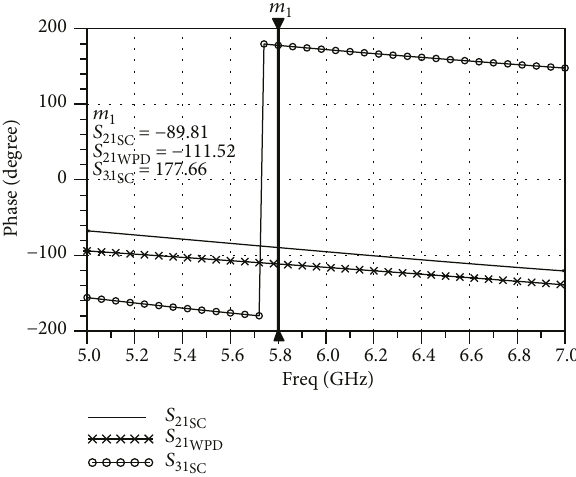
Figure 8: Phases of the scattering parameters of the symmetric coupler (SC) and Wilkinson power divider (WPD) simulated in ADS schematic with C = 7 dB, K = 1 , and R = 100 Ω